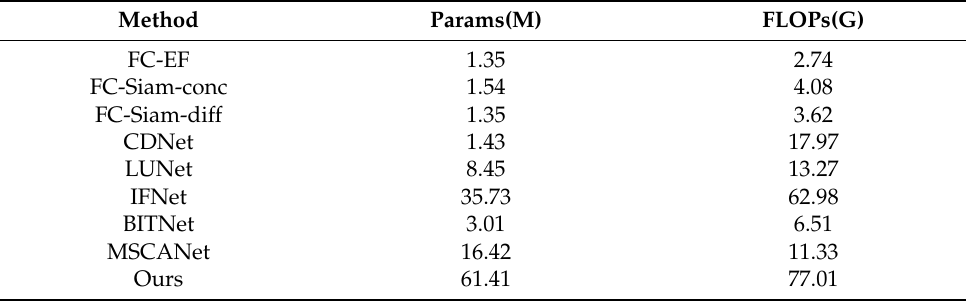
Table 7. Analysis of the computational efficiency of various